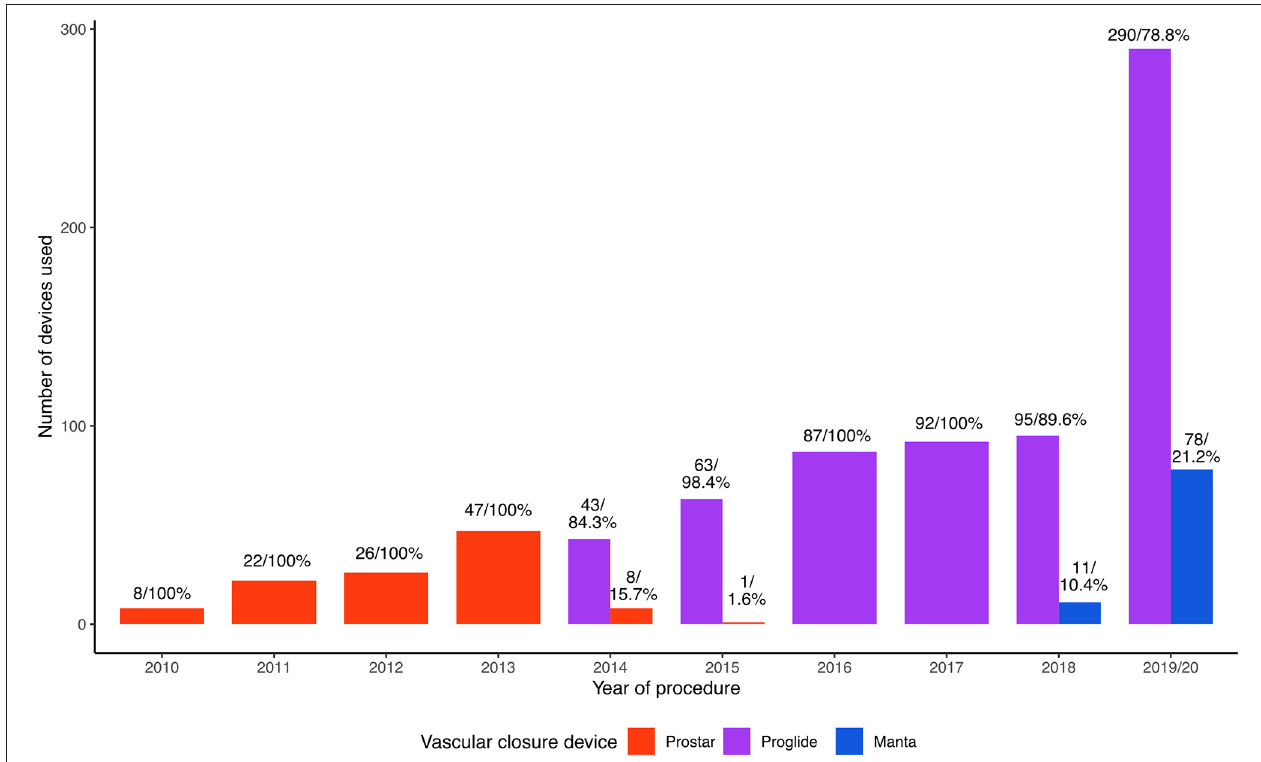
FIGURE 2 | Temporal trends of vascular closure device (VCD) utilization. In the first few years the only used device was the Prostar device. Additionally, rapid adoption of the Proglide (purple) system after its introduction can be